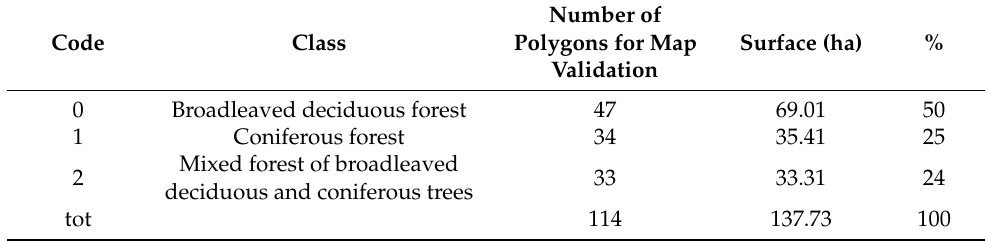
Figure 3. Example of validation sample (EPSG 3004). The limits of the sample and the circular plot are in yellow and blue, respectively. The codes 0, 1, 2 refer to the classes reported in Table 3. Table 4. Distribution of the three forest types classes in the validation